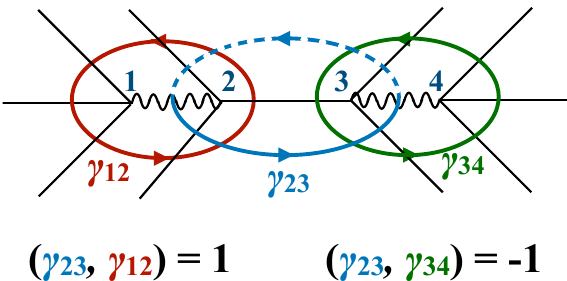
Figure 9 . Intersection number among cycles in the DDP formula. In this case, the intersection numbers of cycles are given by ( γ 23 , γ 12 ) = +1 and ( γ 23 , γ 34 ) = − 1. (See figure 10 for the definition.).